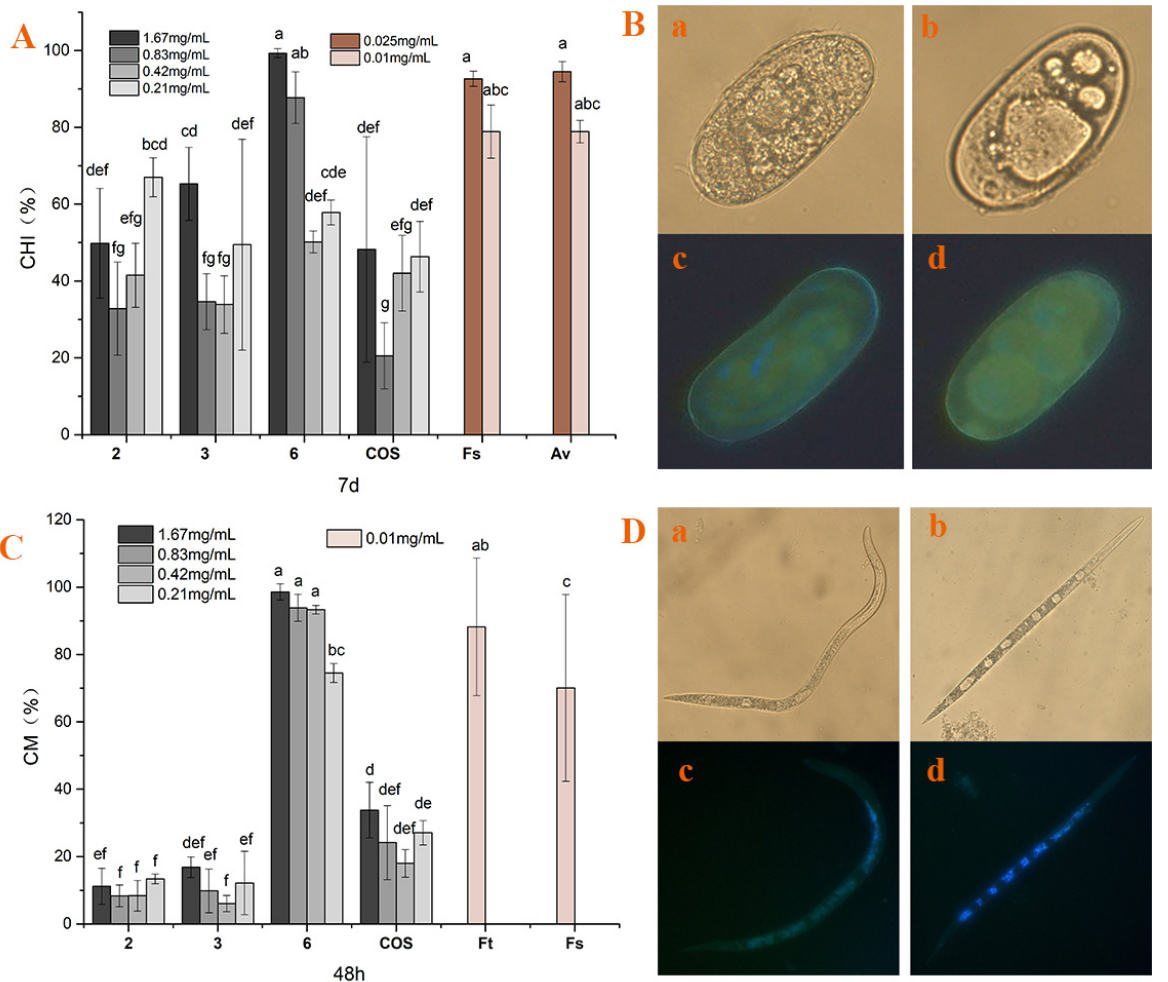
Figure 4. Effects of COS derivatives on eggs and J2s: ( A ) was egg hatching inhibitory activity at 7 d; ( C ) was nematicidal activity at 48 h; ( B ) or ( D ) was the morphology of egg and J2 under stereomicroscope and fluorescence microscope, of which ( a , c ) belong to the blank control, ( b , d ) were treated with 1 mg/mL of derivative 6 . Fs, Ft, and Av represent positive control fluensulfone, fosthiazate, and avermectin, respectively. Different letters (a, b, c, etc.) above histogram mean statistical significance at the p ≤ 0.05 level.